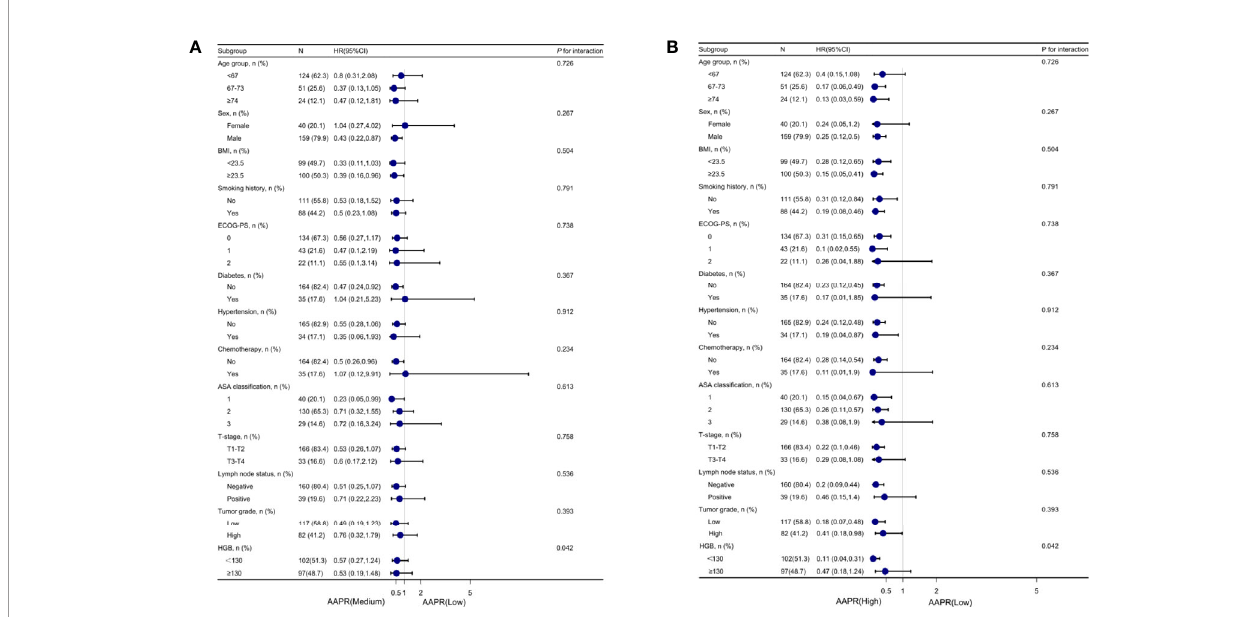
FIGURE 5 | Forest plot for presenting the association between the hazard ratio of overall survival and medium- (A) and high-AAPR (B) in BC patients. AAPR, albumin-to-alkaline phosphatase ratio; BC, bladder cancer.